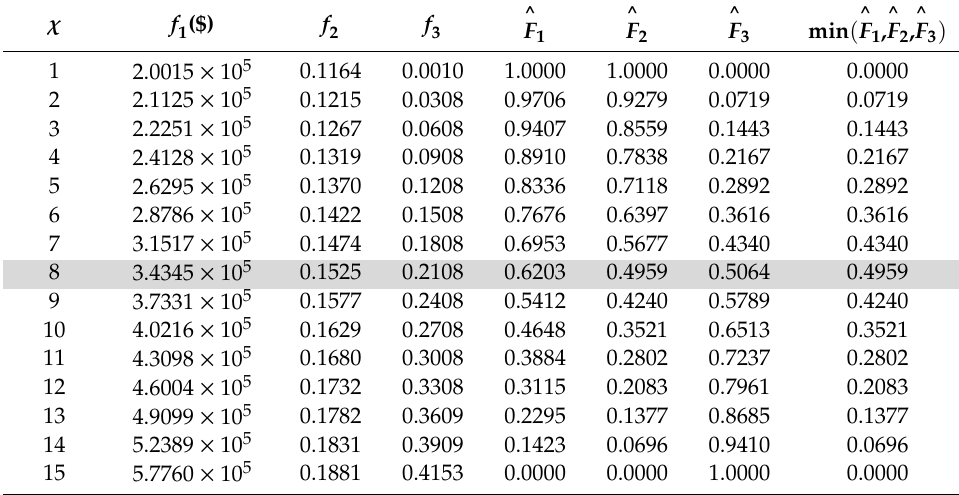
Table 19. Obtained Pareto optimal solutions for the probabilistic multi-objective RPP considering load demand and wind power generation uncertainties incorporating the generated reactive power by the proposed wind